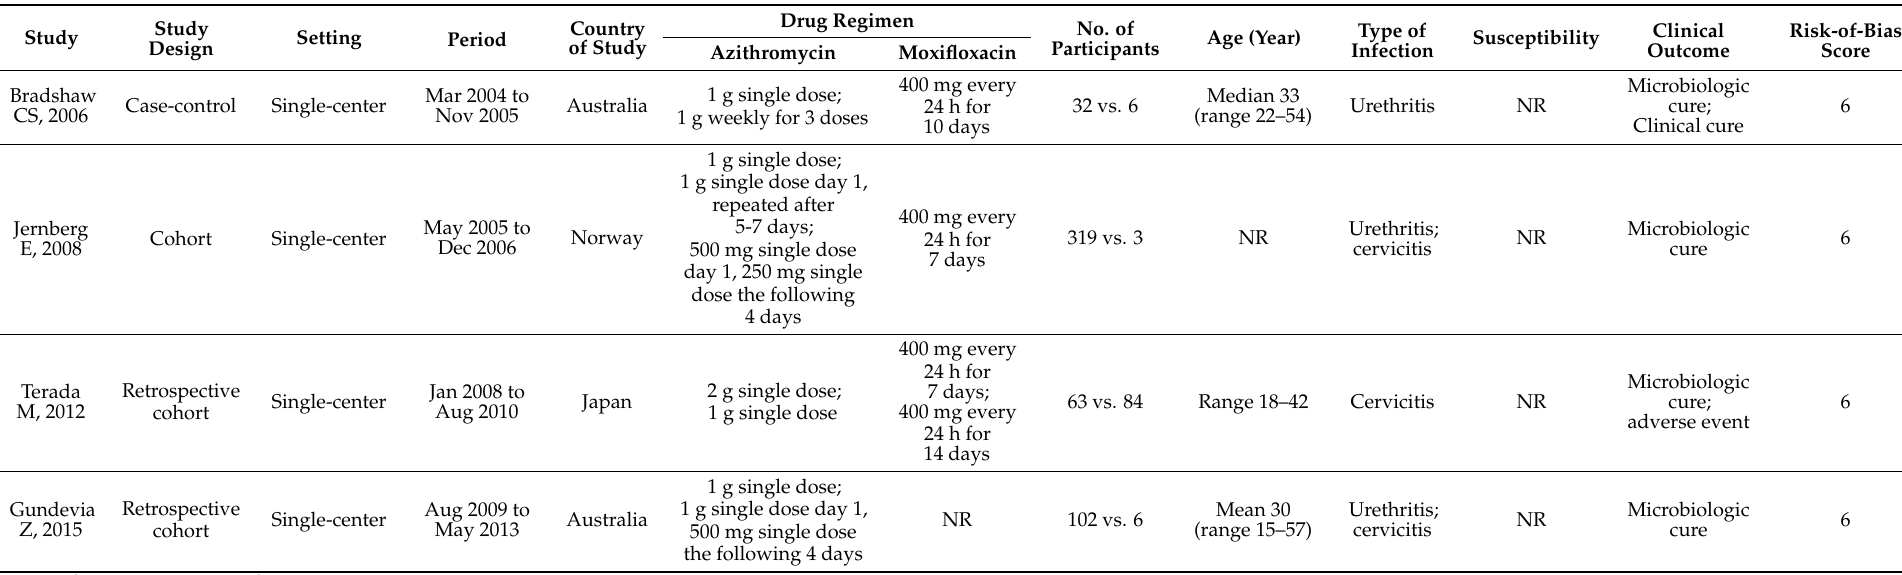
Table 1. Characteristics of the studies included in the